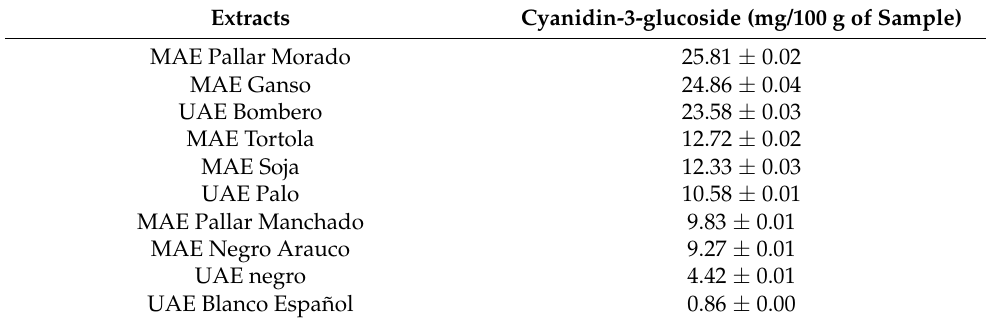
Table 2. Total monomeric anthocyanin on